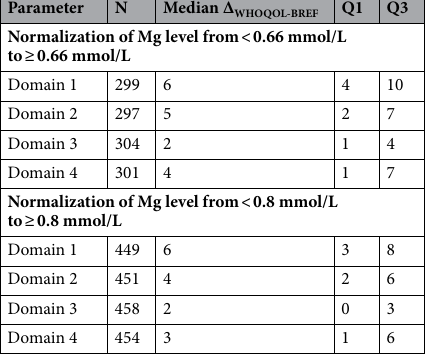
Table 4. Changes in WHOQOL-BREF scores in women with hormone-related conditions in whom total serum Mg level was normalized. Mg magnesium; Q quartile; WHOQOL-BREF World Health Organization quality of life questionnaire; Δ WHOQOL-BREF , difference between Visit 1 and Visit 2 in the total WHOQOL-BREF.